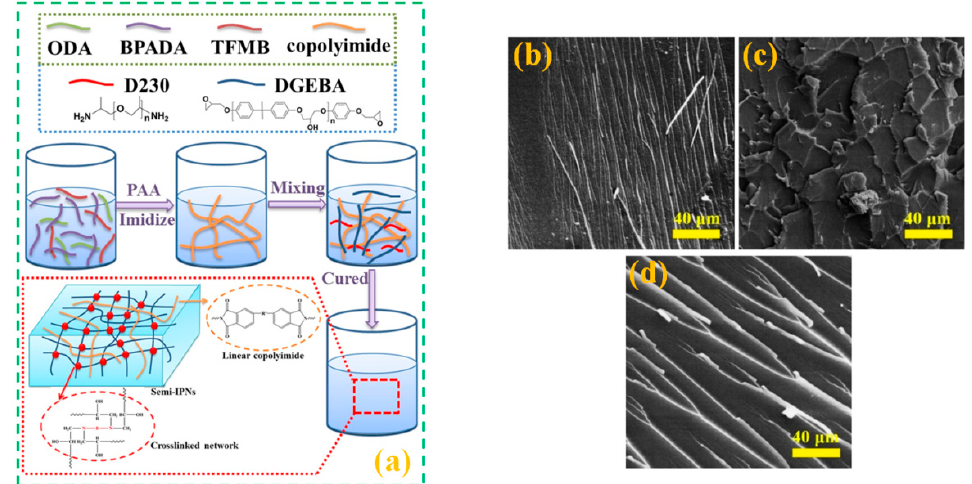
Figure 3. ( a ) Schematics of the synthesis procedure and structure of PI/EP semi-IPN. Reprinted